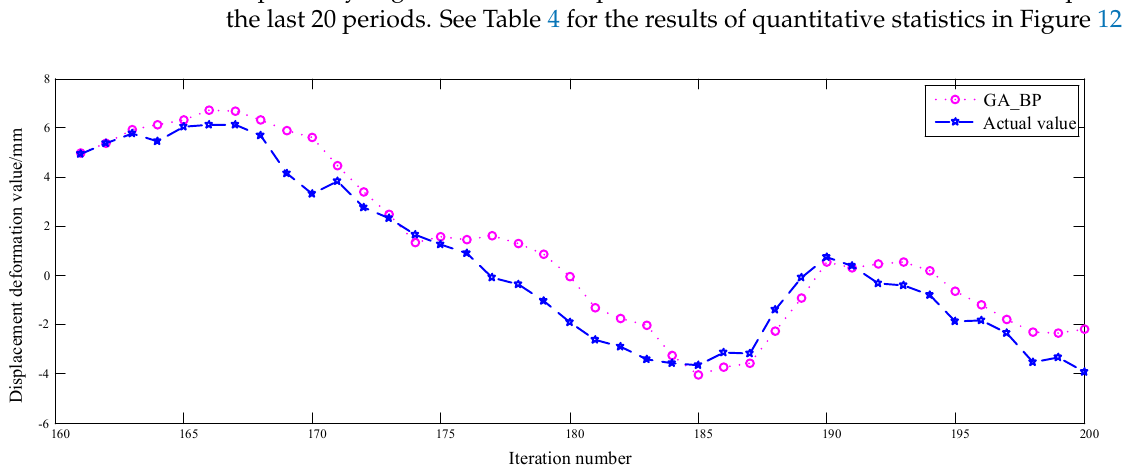
Figure 12. Prediction curve of genetic neural network model . Table 4. Comparison of horizontal displacement prediction results between the ICSO-SVM and GA- BP models.